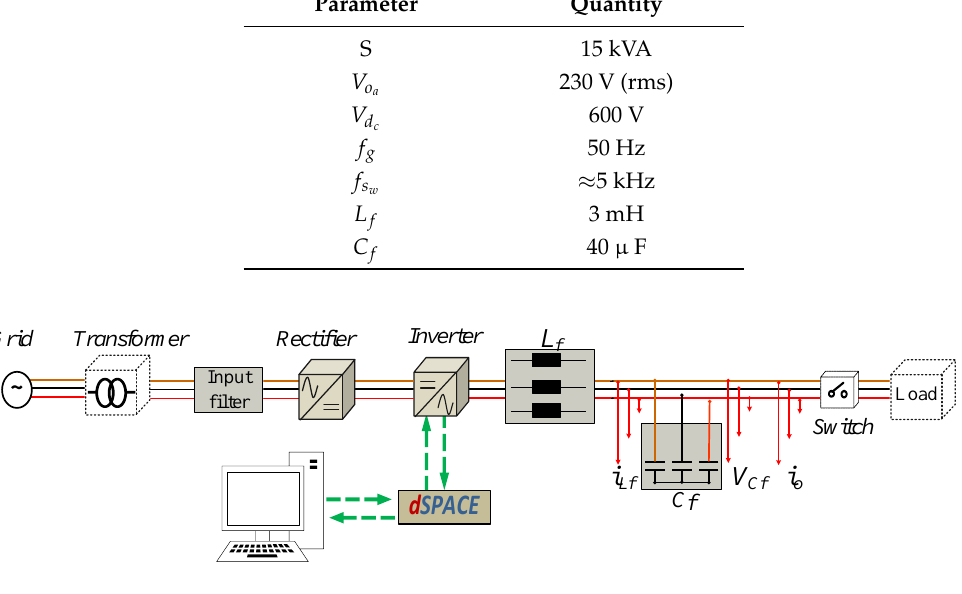
Figure 4. Schematic diagram of the experimental